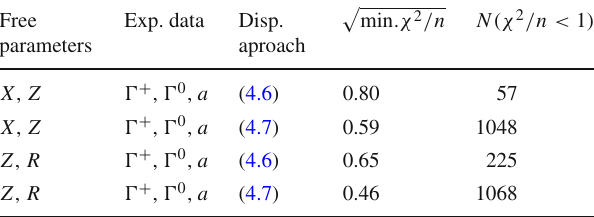
Table 4 χ 2 -based comparison of the dispersive representations Free Exp. parameters